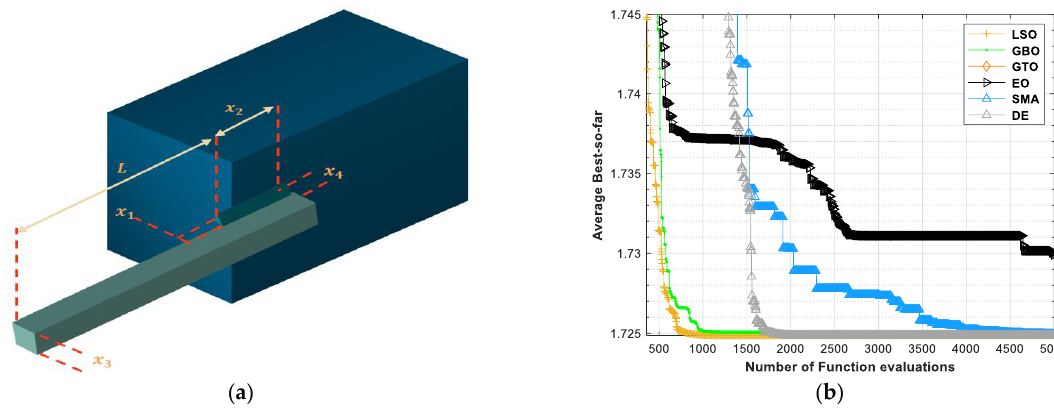
Figure 22. Weld beam design problem. ( a ) Structure. ( b ) Convergence curve. The proposed algorithm is compared with nine additional algorithms from the liter- ature including hybrid and improved ones, which are RO [67], WOA [41], HS [141], hybrid charged system search and particle swarm optimization (PSO) algorithms I (CSS&PSO I) [136], hybrid charged system search and particle swarm optimization (PSO) algorithms II (CSS&PSO II) [136], particle swarm optimization algorithm with struggle selection (PSOStr) [140], RO [67], firefly algorithm (FA) [142], differential evolution with dynamic stochastic selection (DE) [143], and hybrid artificial immune system and genetic algorithm (AIS-GA). As shown in Table 18, on one side, LSO has a competitive result comparing to GBO, GTO, EO, and DE, and superior in terms of the convergence speed as shown in Figure 22b. On the other side, LSO is superior to all the other optimizers. Table 18. Comparison of the results for weld beam design problem. No. Algorithm